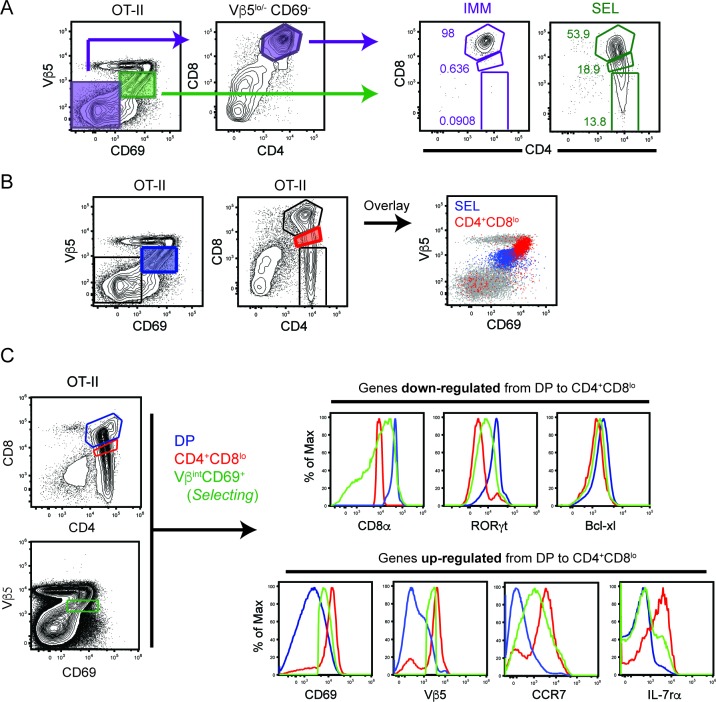
Characterization of Immature and Selecting thymic populations.(A) CD4-versus-CD8 profile of Immature (purple) and Selecting (green) populations in OT-II mice. Immature thymocytes are gated as Vβ5-/loCD69- CD4+CD8+. Selecting thymocytes are gated as Vβ5intCD69+. (B) Overlay of Selecting (blue) and CD4+CD8lo (red) populations on a Vβ5-versus-CD69 profile in OT-II mice. Grey dots on the Vβ5/CD69 plot depict total thymocytes. Data is representative of 3 mice from three independent experiments. (C) Selecting cells show intermediary marker expression between DP and CD4+CD8lo thymocytes. Expression of ‘down-regulated’ genes (CD8α, RORγt, Bcl-xl) and ‘up-regulated’ genes (CD69, TCR, CCR7, IL-7Rα) on DP, CD4+CD8lo, and Selecting cells from OT-II mice. Data is representative of 3 mice from three independent experiments.